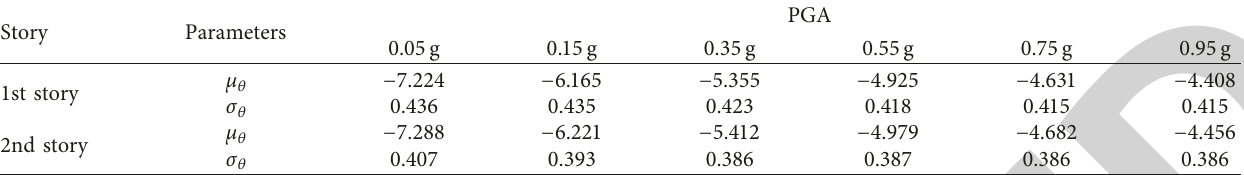
Table 2: Distribution parameters for maximum interstory drift.